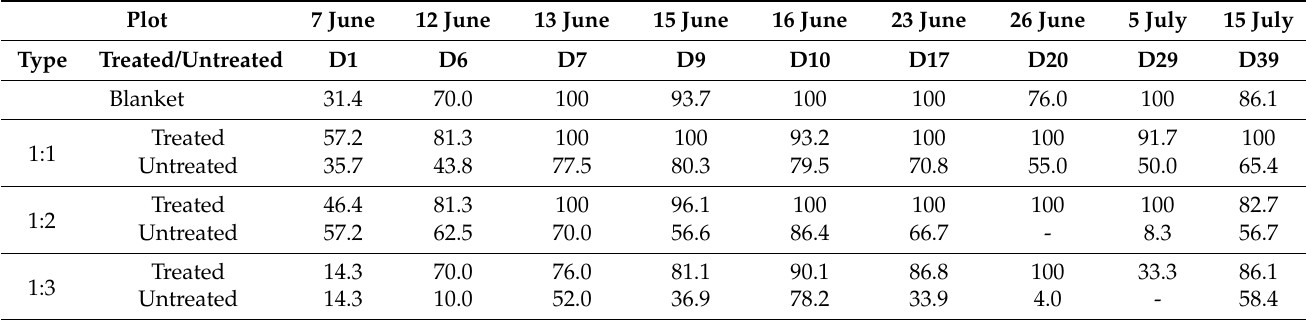
Table 4. Effectiveness (%) of teflubenzuron treatments (6 June) on the experimental site in the northern part of the Kulunda steppe (near Aleksandrovskij settlement) in